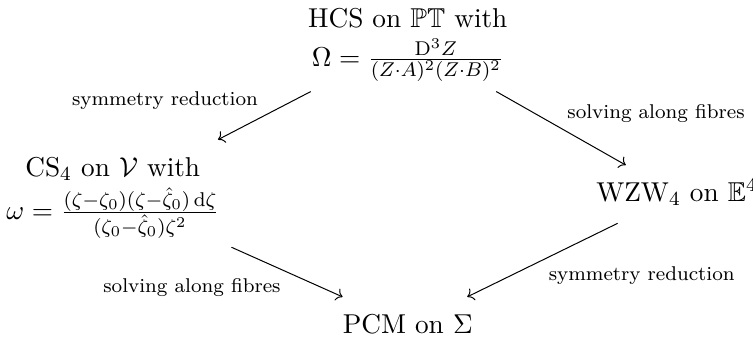
Figure 2 . A guide to the relationship between the principal chiral model, 4d WZW model and their respective 4d Chern-Simons, twistor